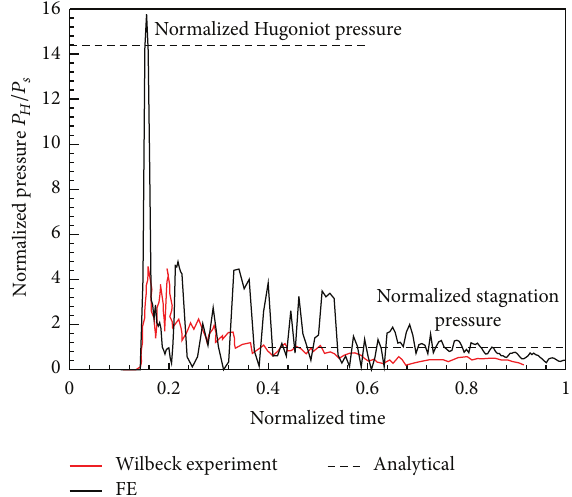
Figure 4: Comparison of results for Hugoniot pressure.